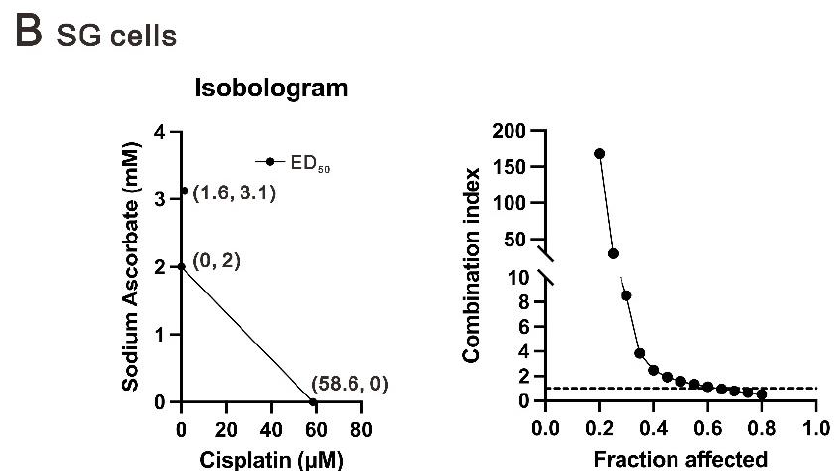
Figure 9. Combination index of cisplatin with sodium ascorbate in OECM-1 and SG cells. ( A ) OECM-1 (2 × 10 4 ) and ( B ) SG (1.7 × 10 4 ) cells were cultured in 24-well plates and treated with sodium ascorbate dose: 0, 0.1, 0.25, 0.5, 1, 3, 5, 8, 10, and 20 mM combined with cisplatin dose: 0, 0.1, 0.25, 0.5, 1, 5, 10, and 20 μM. Cell viability was measured by the MTT method. The combination index of cisplatin plus specific drug in ( A ) OECM-1 and ( B ) SG cells. Isobolograms (ED 50 ) of cisplatin were calculated using CalcuSyn software.